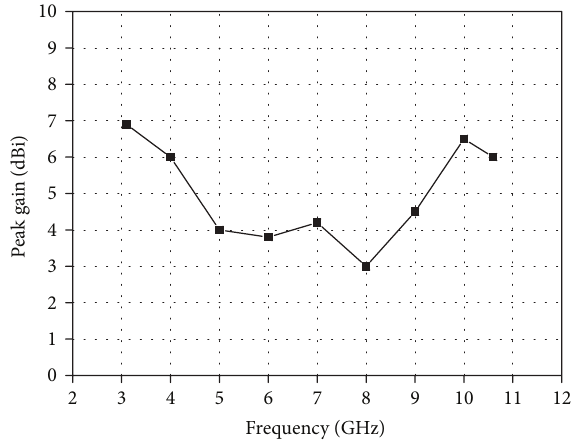
Figure 6: Measured peak antenna gain across the UWB for port 1